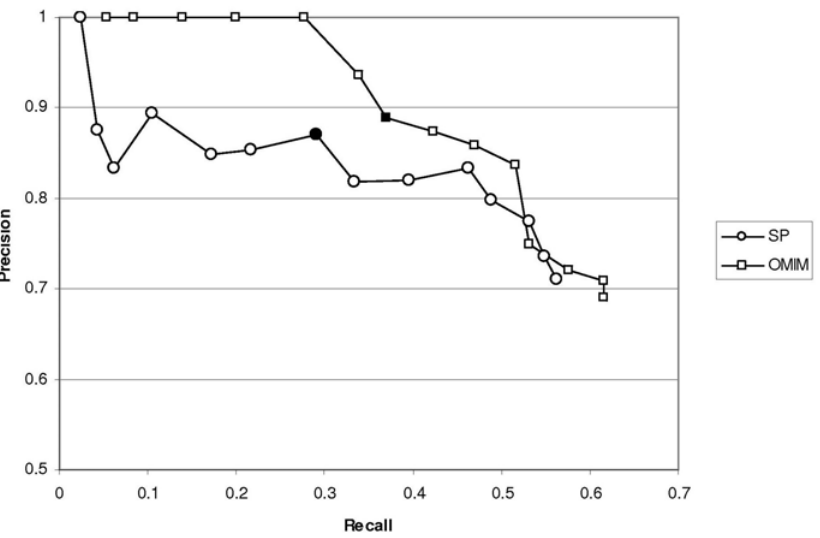
Figure 2: Recall-precision at each integer unit of the similarity score in the interval [-7,+7]. The black points correspond to the recall/precision at the selected score threshold